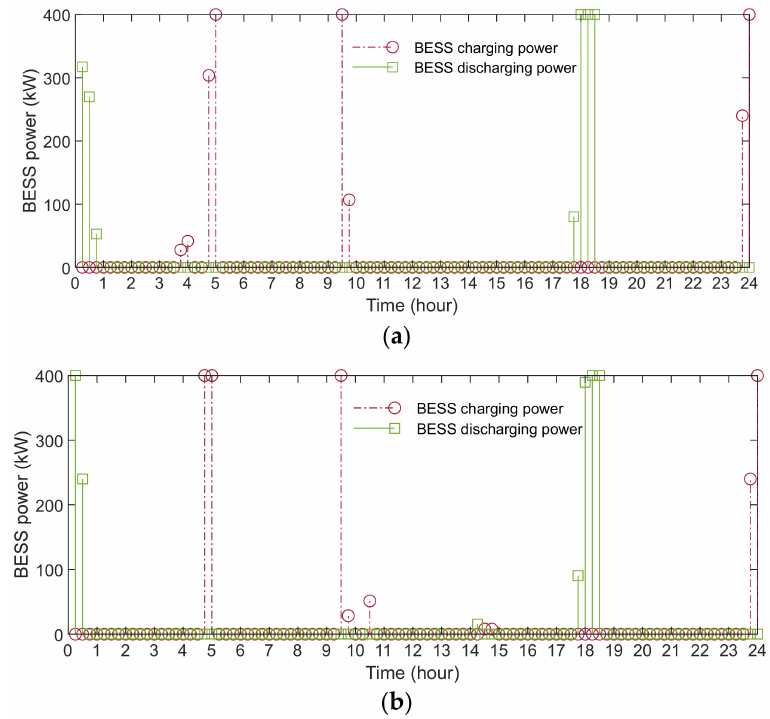
Figure 14. BESS charging/discharging power variations: ( a ) load type A ( b ) load type